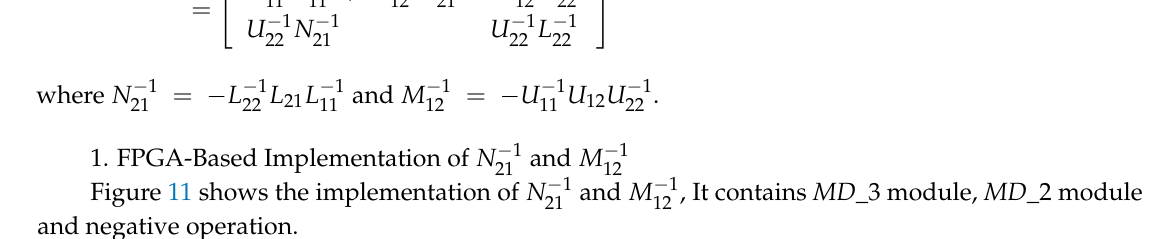
Figure 11. Implementation of N − 1